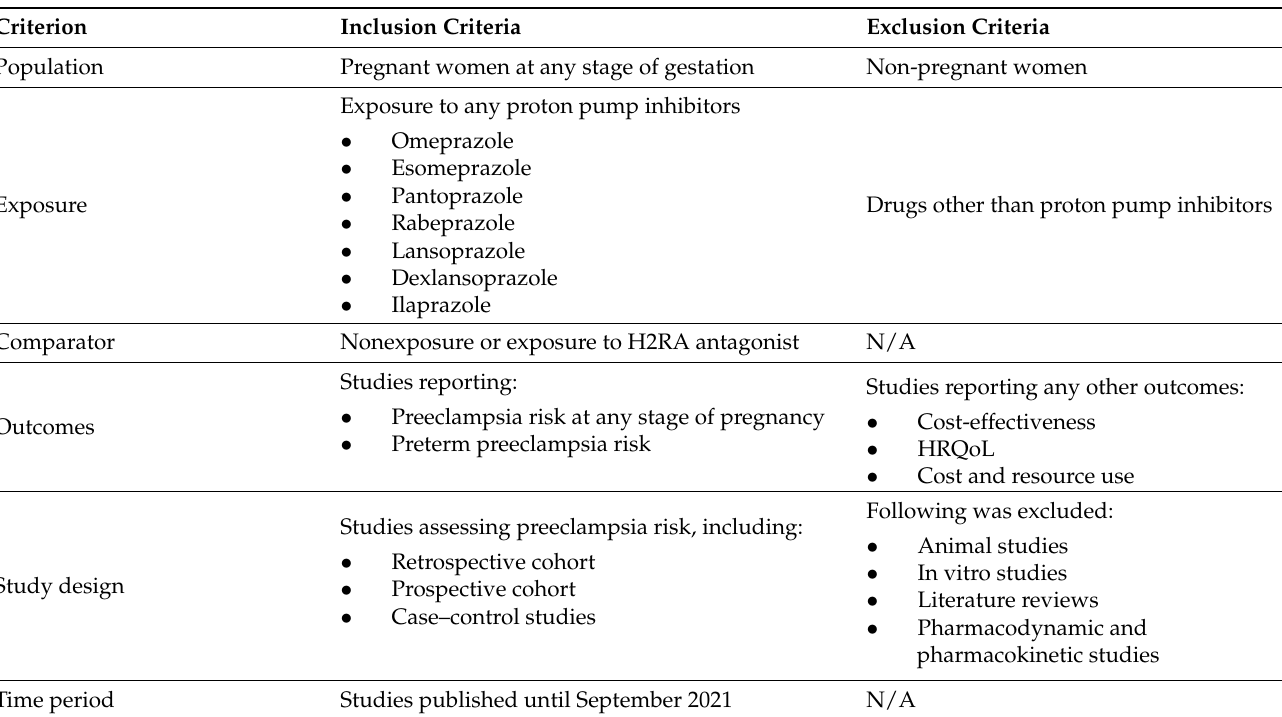
Table 1. Eligibility criteria for the selection of